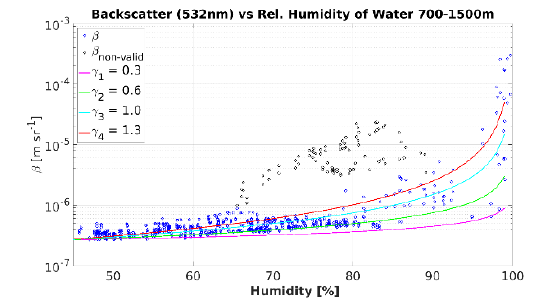
Fig.02 : Backscattering versus humidity with fitted growth functions for different growth parameters.